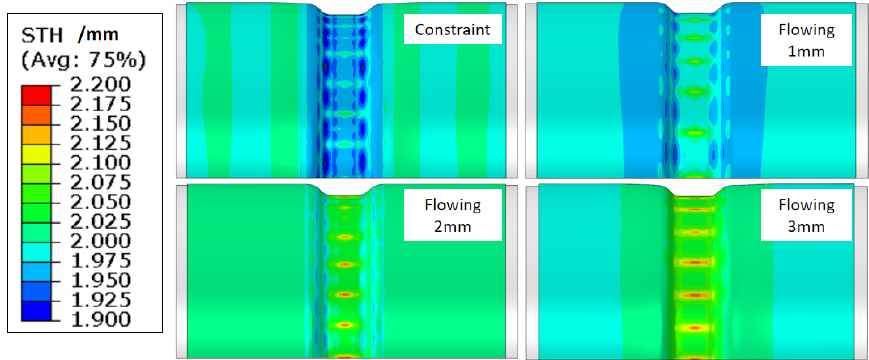
Figure 17. Variation of thickness distribution under different material flowing displacements.